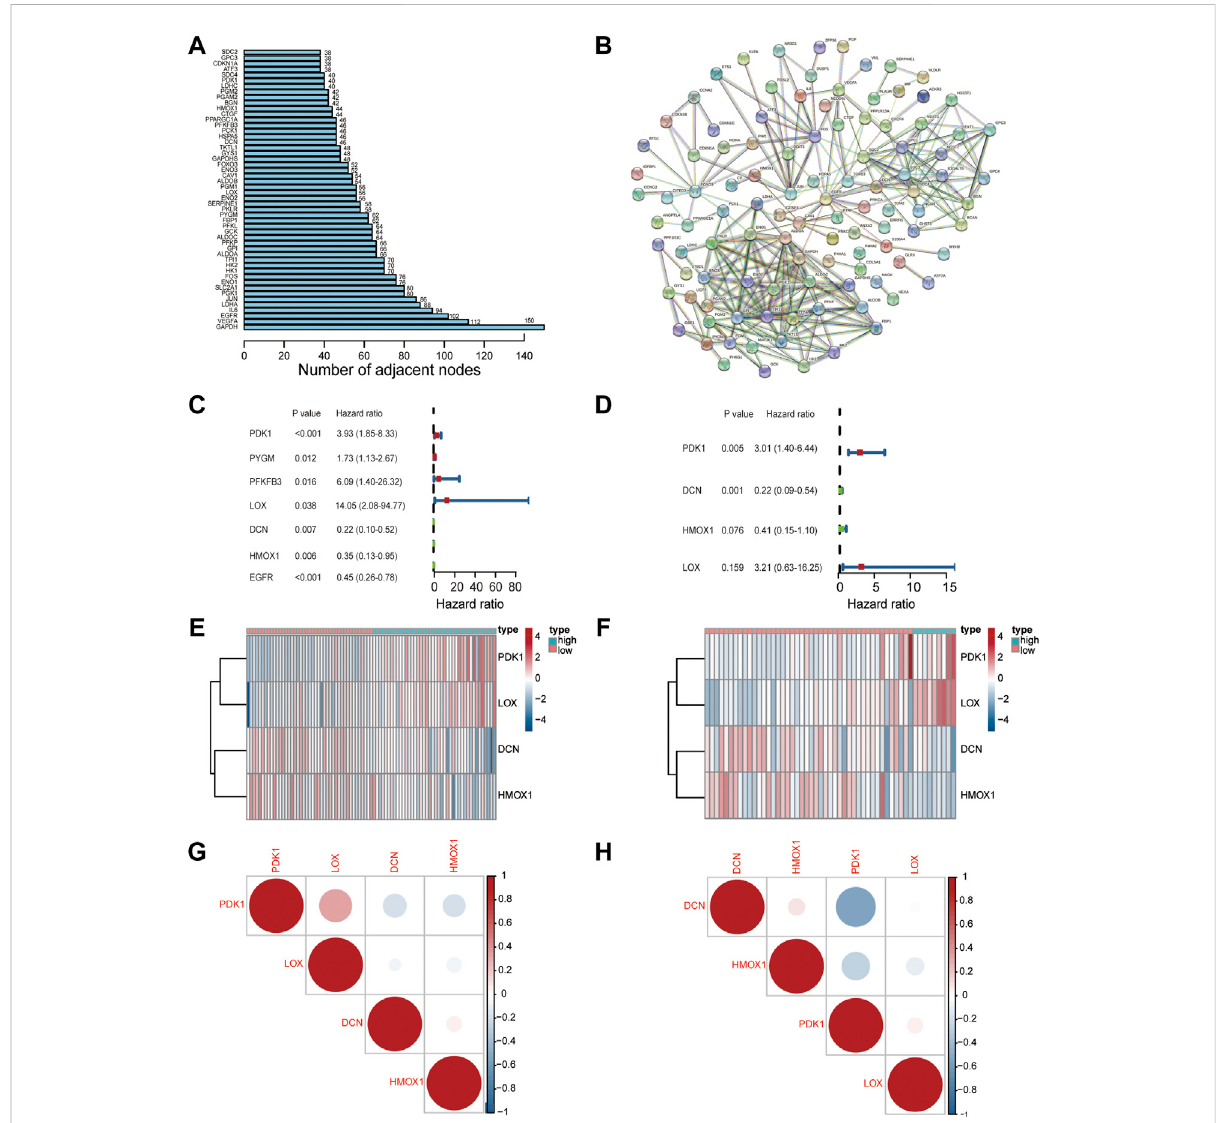
FIGURE 2 Characterization of a hypoxia risk model to predict prognosis of OS. (A) The number of adjacent nodes per hypoxia-related gene; (B) PPI network indicating the correlation of HRGs; (C,D) A hypoxia-risk model was evaluated by univariate and multivariate Cox regression; (E,F) Heatmap displaying expressions of hypoxia-related DEGs and comparison between high and low hypoxia risk groups in TARGET (E) and GEO databases (F) ; (G,H) Correlation analysis of hub gene in TARGET (G) and GEO databases (H)